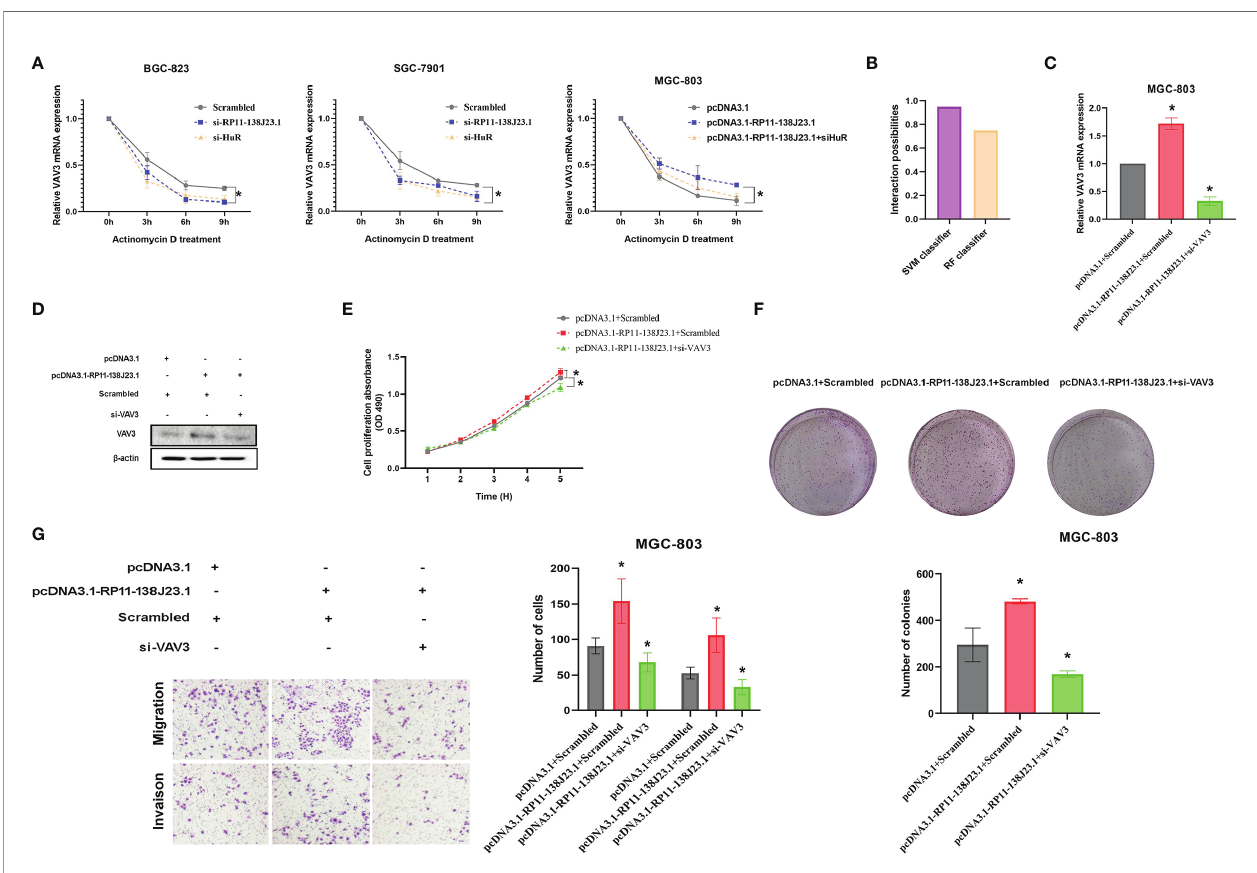
FIGURE 7 | RP11-138J23.1 and HuR could increase VAV3 stability. (A) RNA stability assays were performed to measure degradation rates of VAV3 mRNA in BGC-823 and SGC-7901 cells with RP11-138J23.1 or HuR knockdown. In addition, RNA stability assays were also performed to measure degradation rates of VAV3 mRNA in MGC-803 cells with pcDNA3.1, pcDNA3.1-RP11-138J23.1, or pcDNA3.1-RP11-138J23.1+si HuR (B) . (C) The VAV3 mRNA expression level in MGC-803 cells transfect with pcDNA3.1+Scrambled, pcDNA3.1-RP11-138J23.1+Scrambled, and pcDNA3.1-RP11-138J23.1+si-VAV3. (D) The VAV3 protein expression level in MGC-803 cells transfect with pcDNA3.1+Scrambled, pcDNA3.1-RP11-138J23.1+Scrambled, and pcDNA3.1-RP11-138J23.1+si-VAV3. (E) MTT assays were used to measure the growth curve of pcDNA3.1+Scrambled, pcDNA3.1-RP11-138J23.1+Scrambled, and pcDNA3.1-RP11-138J23.1+si-VAV3- transfected MGC-803 cells. (F) Colony-forming assays were conducted to determine the proliferation of pcDNA3.1+Scrambled, pcDNA3.1-RP11-138J23.1+Scrambled, and pcDNA3.1-RP11-138J23.1+si-VAV3-transfected MGC-803 cells. (G) Transwell assays were used to determine the cell metastatic ability of pcDNA3.1+Scrambled, pcDNA3.1-RP11-138J23.1+Scrambled, and pcDNA3.1-RP11-138J23.1+si-VAV3-transfected MGC-803 cells. The data represent the mean ± SD from three independent experiments. * p < 0.05; ** p <